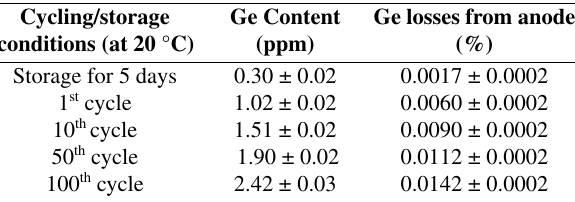
Table 4. Ge content by metal dissolution in the electrolyte (EC:DEC (3:7), 1M LiPF ) after cycling or storage of Ge electro- 6 des, detected by the TXRF method. Fe and Zn losses (%) are rela- ted to the sample weight. electrolyte solution: 100 μL; active mate- rial of Ge: 1.51 mg cm –2 ; the error for the active material (Ge) is 0.02 mg cm –2